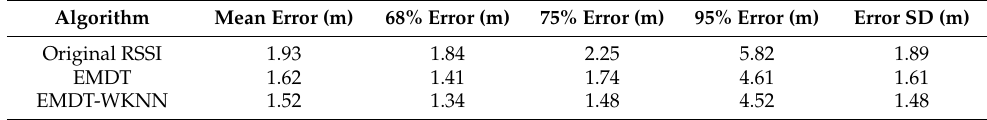
Figure 16. CDF of positioning error. Table 4. Positioning errors under different measures